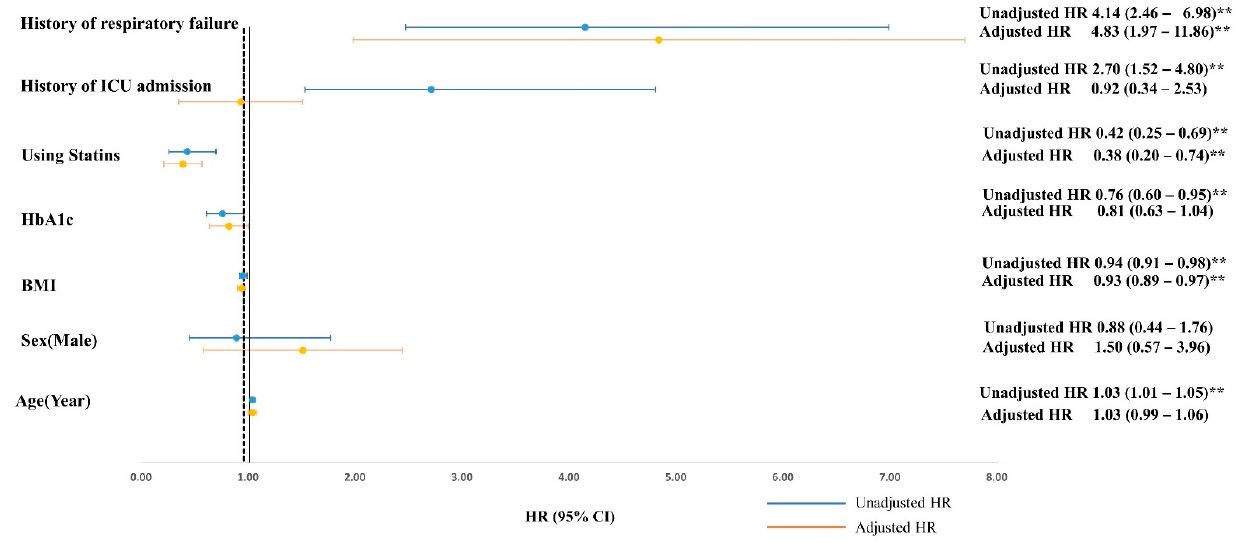
Figure 2. Cox regression model for survival analysis. Multivariate analysis adjusted with BMI, using statin and respiratory failure. ** p < 0.01. ICU: intensive care unit.